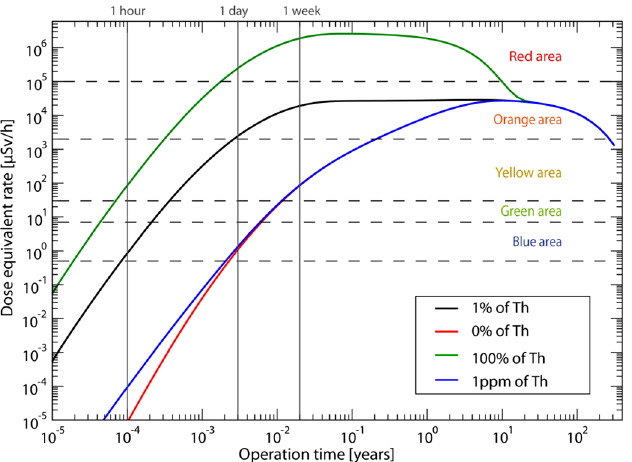
Fig. 2. Evolution of the dose equivalent rate of a fuel salt batch in the storage area of the chemical cleaning unit for four scenarios of thorium extraction, with a mention to the 5 areas de fi ned by the French classi fi cation [9]. The case “ 0% of thorium ” (red curve) is the weaker concerning proliferation resistance since the dose equivalent rate is the lower during the fi rst hours.